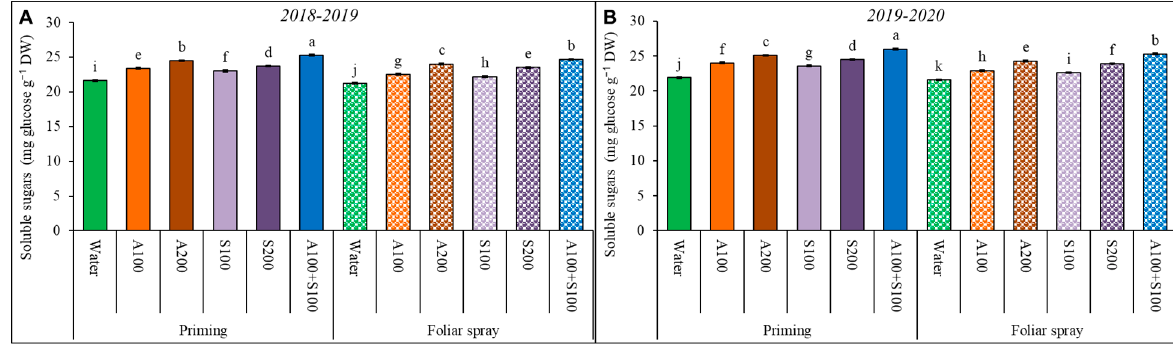
Figure 4. Wheat leaf soluble sugar content affected by AA and SA treatments at 80 DAS during the two winter seasons ( A ) 2018/2019 and ( B ) 2019/2020. Data are mean ± standard error ( n = 4). Letters represent significant differences between treatments at p < 0.05 level according to LSD test.